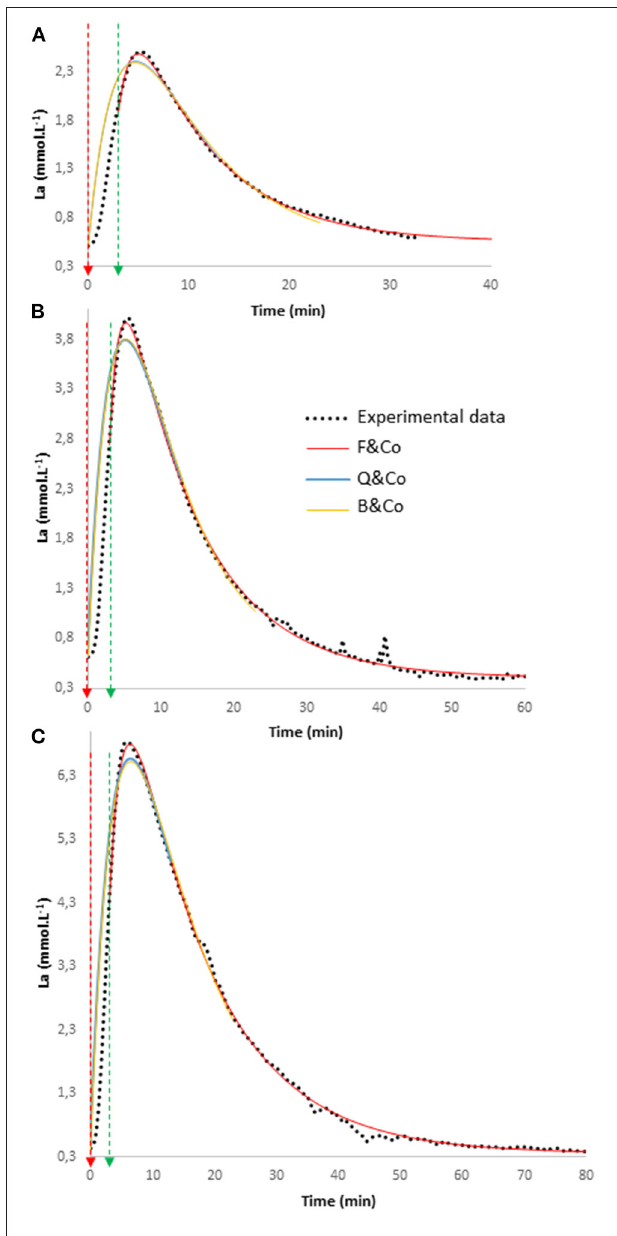
FIGURE 1 | Three experimental blood lactate concentration (La) curves obtained in the same subject during 3-min exercises and the following recoveries at three different exercise intensities [easy (A) , moderate (B) , and heavy (C) , respectively] and the fits from Equations 1–3 applied as Freund and co-workers (F&co), Beneke and co-workers (B&co), and Quittmann and co-workers (Q&co) did (see